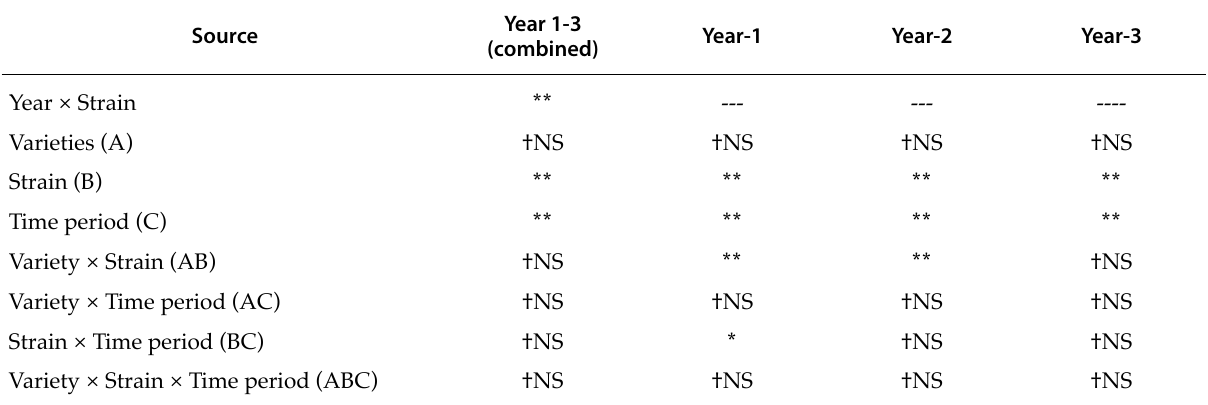
Table 6. Analysis of variance table for biocontrol activity of bacterial the strains against Colletotrichum falcatum on two va- rieties of sugarcane plants in “soil inoculation”